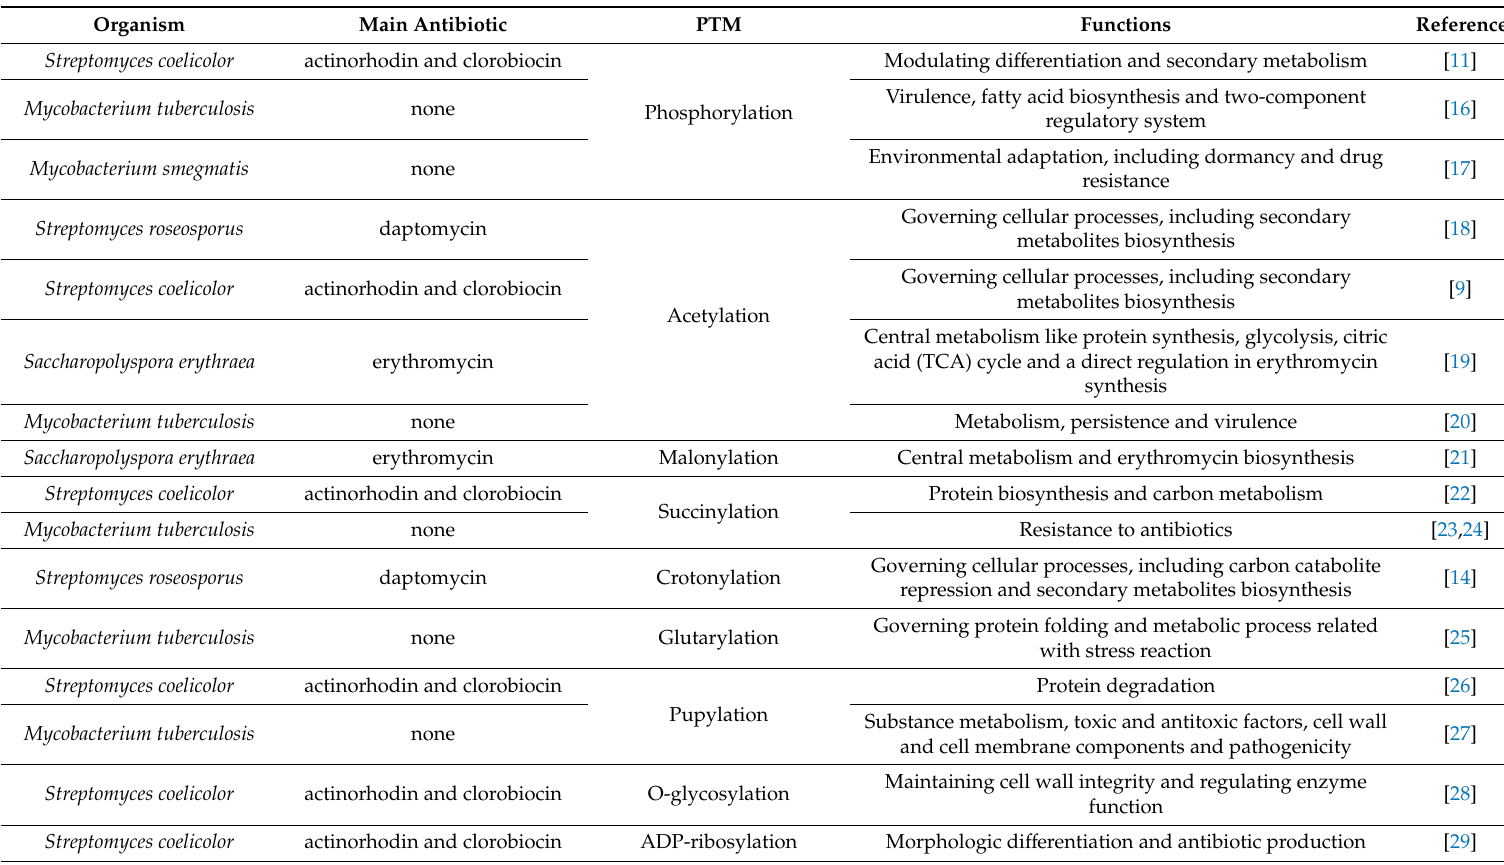
Table 1. Main types of PTMs in